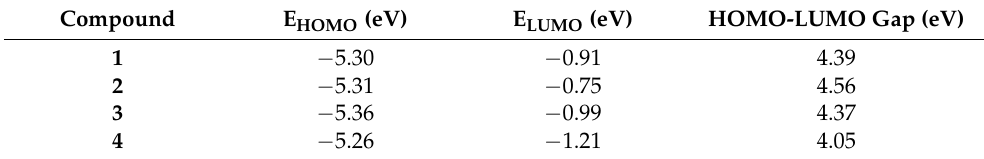
Table 2. Energies of HOMO and LUMO orbitals for compounds 1 – 4